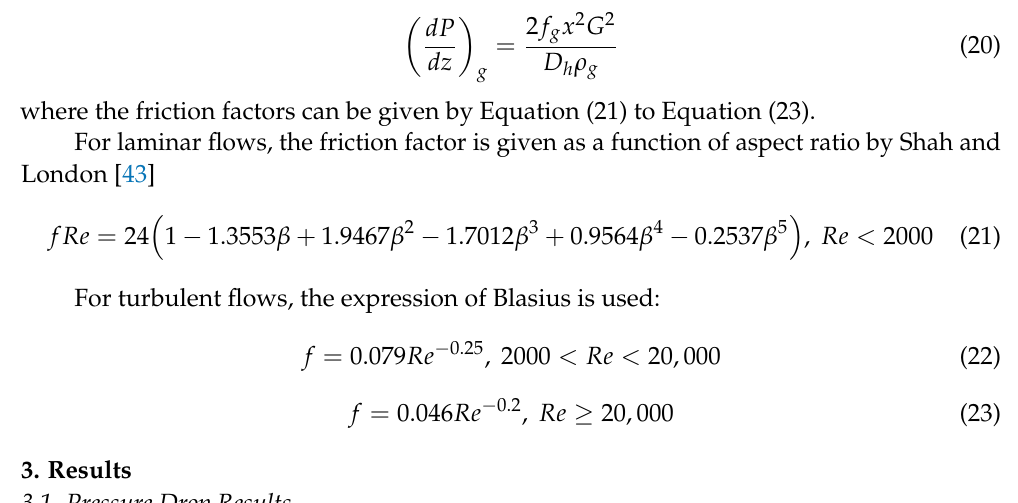
Figure 5. Variation of the two-phase frictional multiplier ( 𝜙 (cid:3039)(cid:2870) ) with respect to the vapor quality un- der different mass velocities Figure 6. Variation of the two-phase frictional multiplier ( 𝜙 (cid:3039)(cid:2870) ) with respect to the Lockhart and Mar- tinelli parameter under different mass velocities